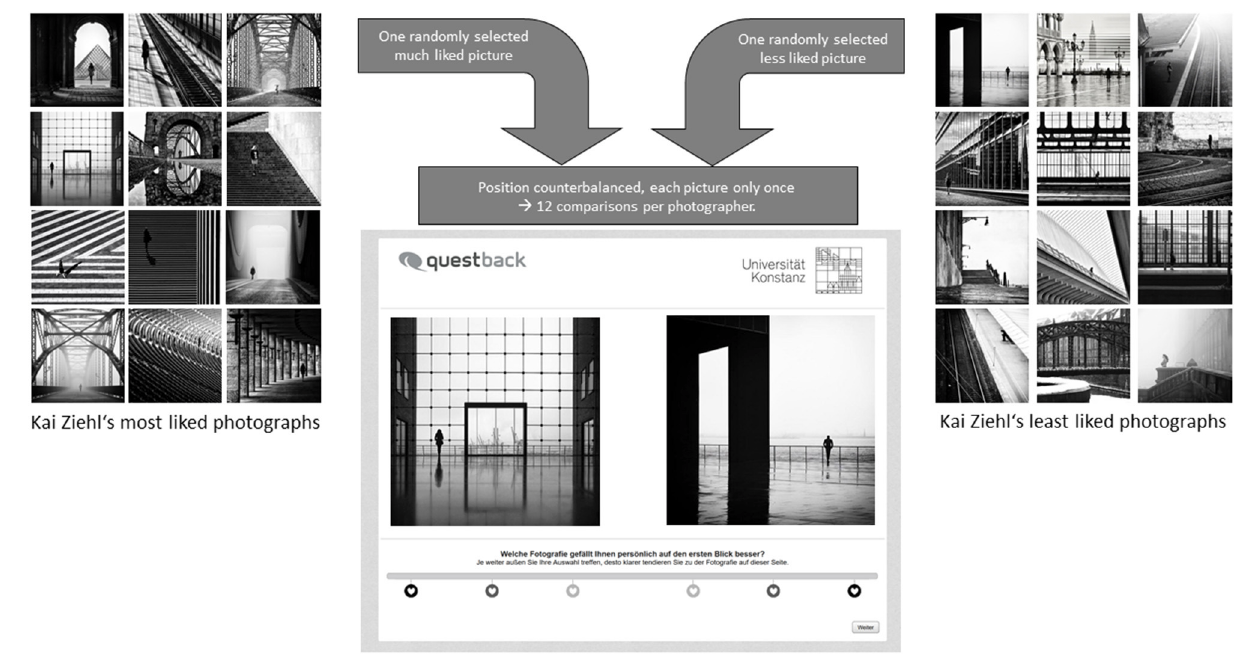
FIGURE 4 | Experimental design explained with the example of Kai Ziehl’s most and least liked photographs on Instagram. Participants had to make 12 decisions per photographer. We used images of two photographers classified by the number of Instagram Likes and of two additional photographers sorted by balance scores. This resulted in 24 Liking and 24 Balance judgments per participant. Each picture had an extension of 640 640 pixels. The original German question was “Welche × Fotografie gefällt Ihnen persönlich auf den ersten Blick besser?” (engl. Which photo do you like better at first glance?) and “Welche Bildkomposition ist Ihrer Einschätzung nach in Bezug auf Helligkeit besser ausbalanciert?” (engl. Which photograph has a more balanced composition in respect to its distribution of brightness?) respectively.